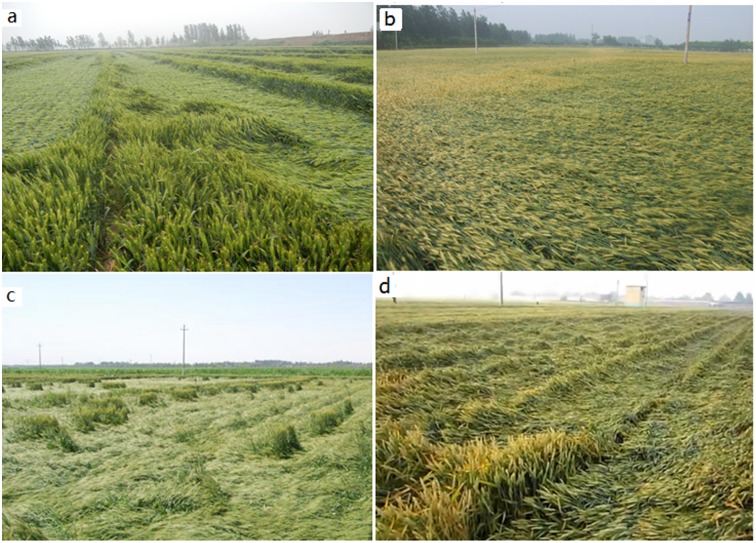
Lodging due to strong winds accompanied by heavy rainfall.a. Chiping county, Shandong (05/27/2013). b. Weishi county, Henan (05/17/2008). c. Wulatezhongqi, Inner Mongolia Autonomous Region (06/28/2012). d. Shouguang city, Shandong (06/02/2012).